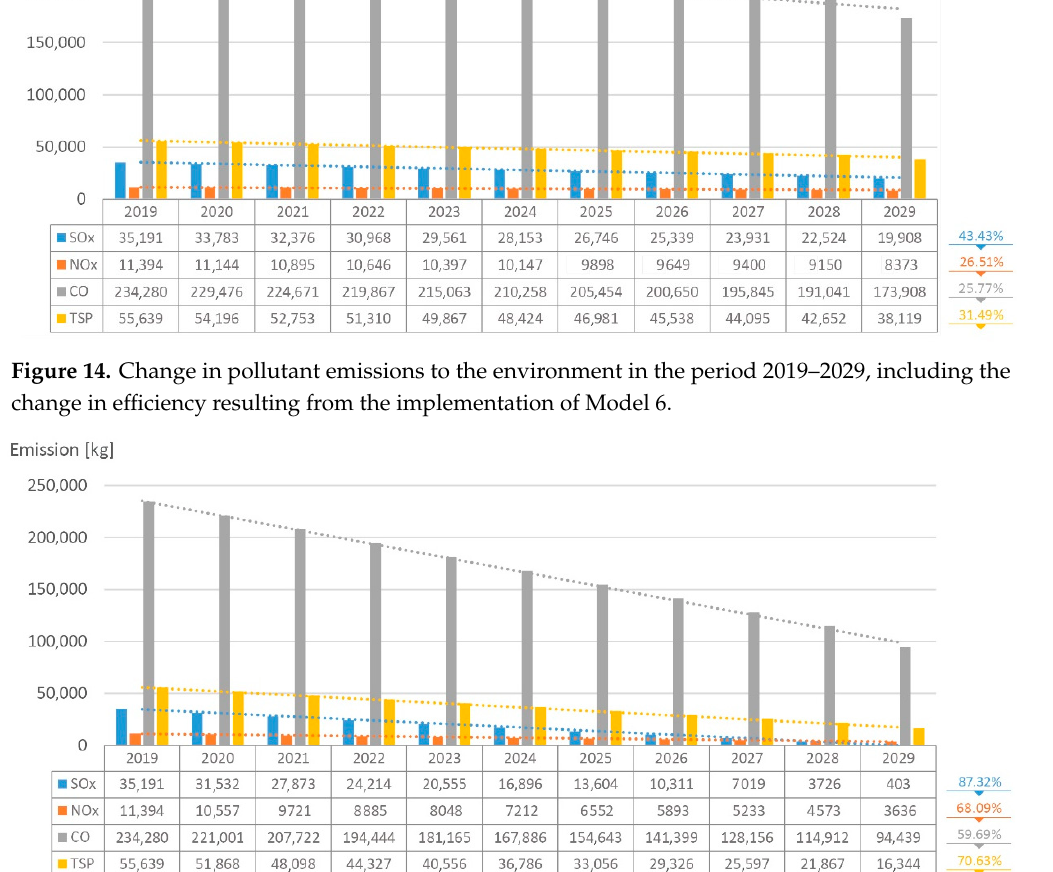
Figure 15. Change in pollutant emissions to the environment in the period 2019–2029, including the change in efficiency resulting from the implementation of Model 7.